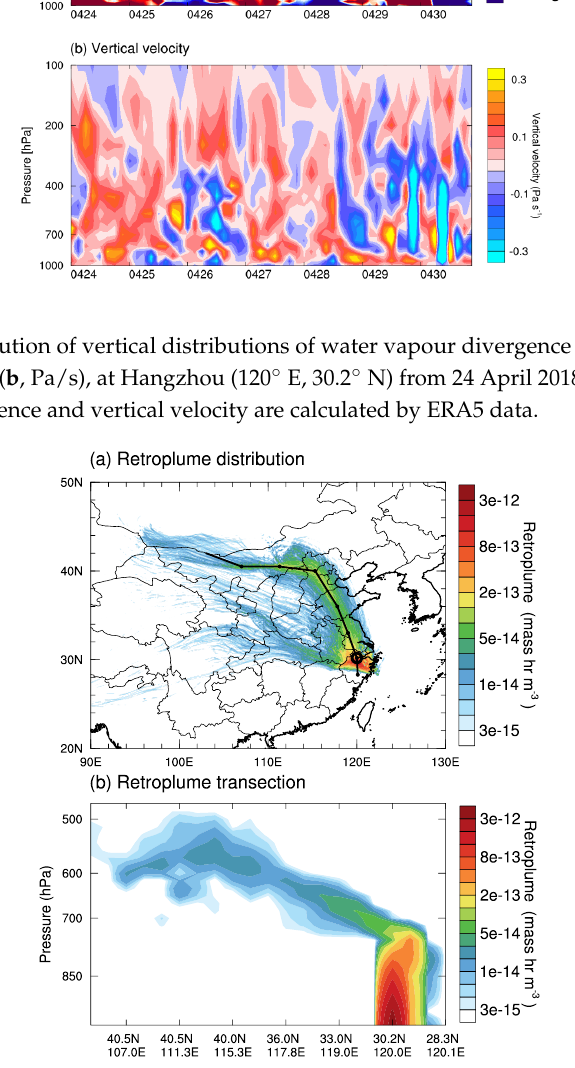
Figure 11. ( a ) 24-h backward column retroplume (integrated for all levels) of particles released at the altitude of 100 m above Hangzhou (120 ◦ E, 30.2 ◦ N) at 16:00 (local time) on 28 April 2018. ( b ) Vertical distribution of particle retroplume along the air path as indicated by the black dotted line in Figure